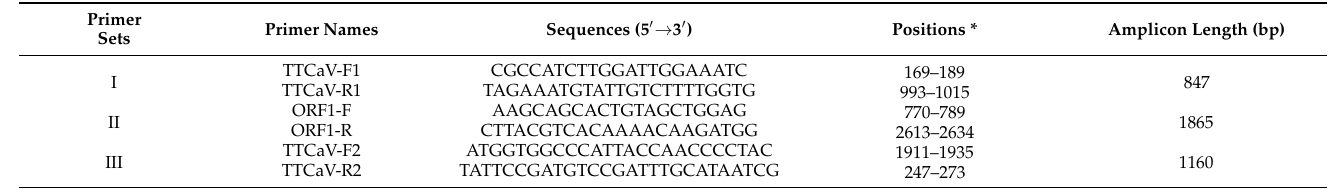
Table 1. Primer sets used for the detection of partial and full TTCaV genomic